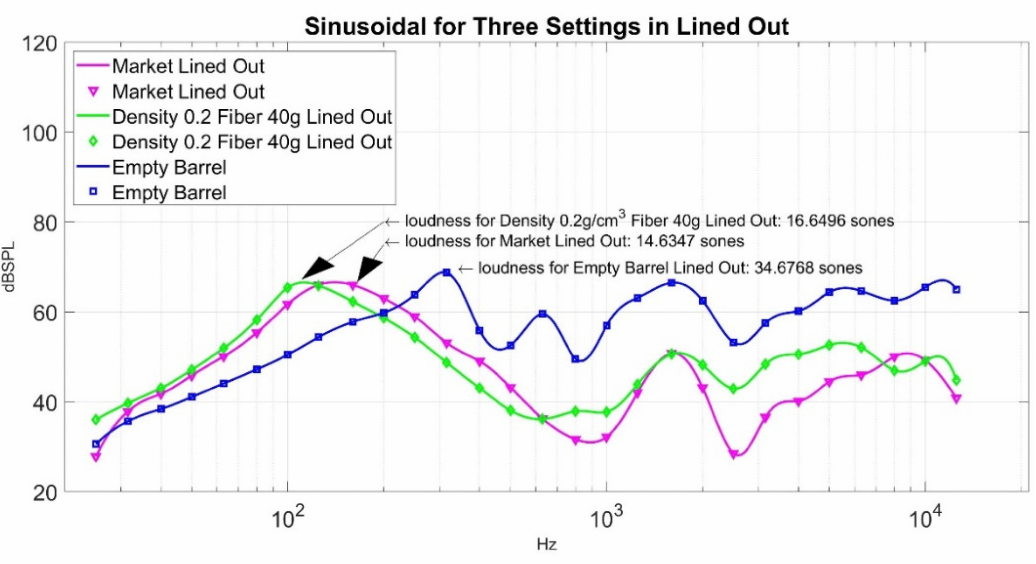
Figure 19. A comparison of sound pressure level curves for three settings in Lined Out.